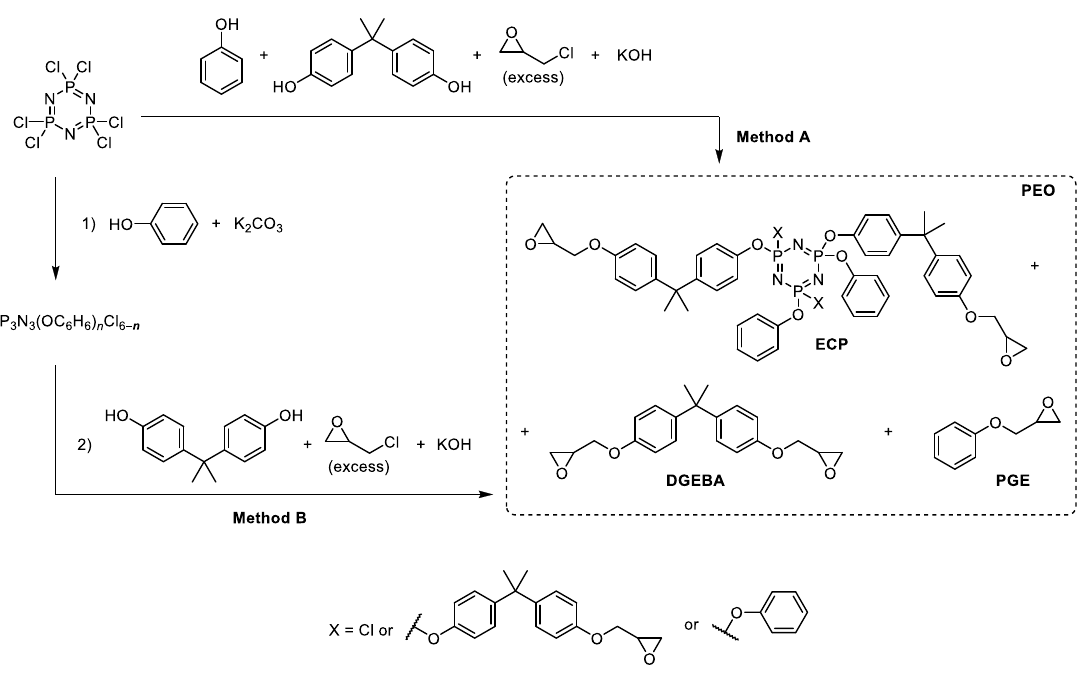
Figure 3. Single-stage synthesis of phosphazene-containing epoxy oligomers by direct interaction of hexachlorocyclotriphosphazene (HCP), phenol and bisphenol A in epichlorohydrin medium (this work).